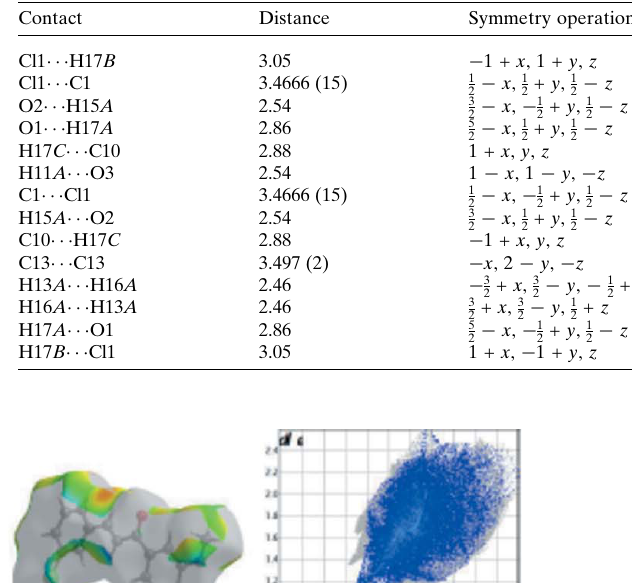
Table 2 Summary of short interatomic contacts (A˚ ) in the title